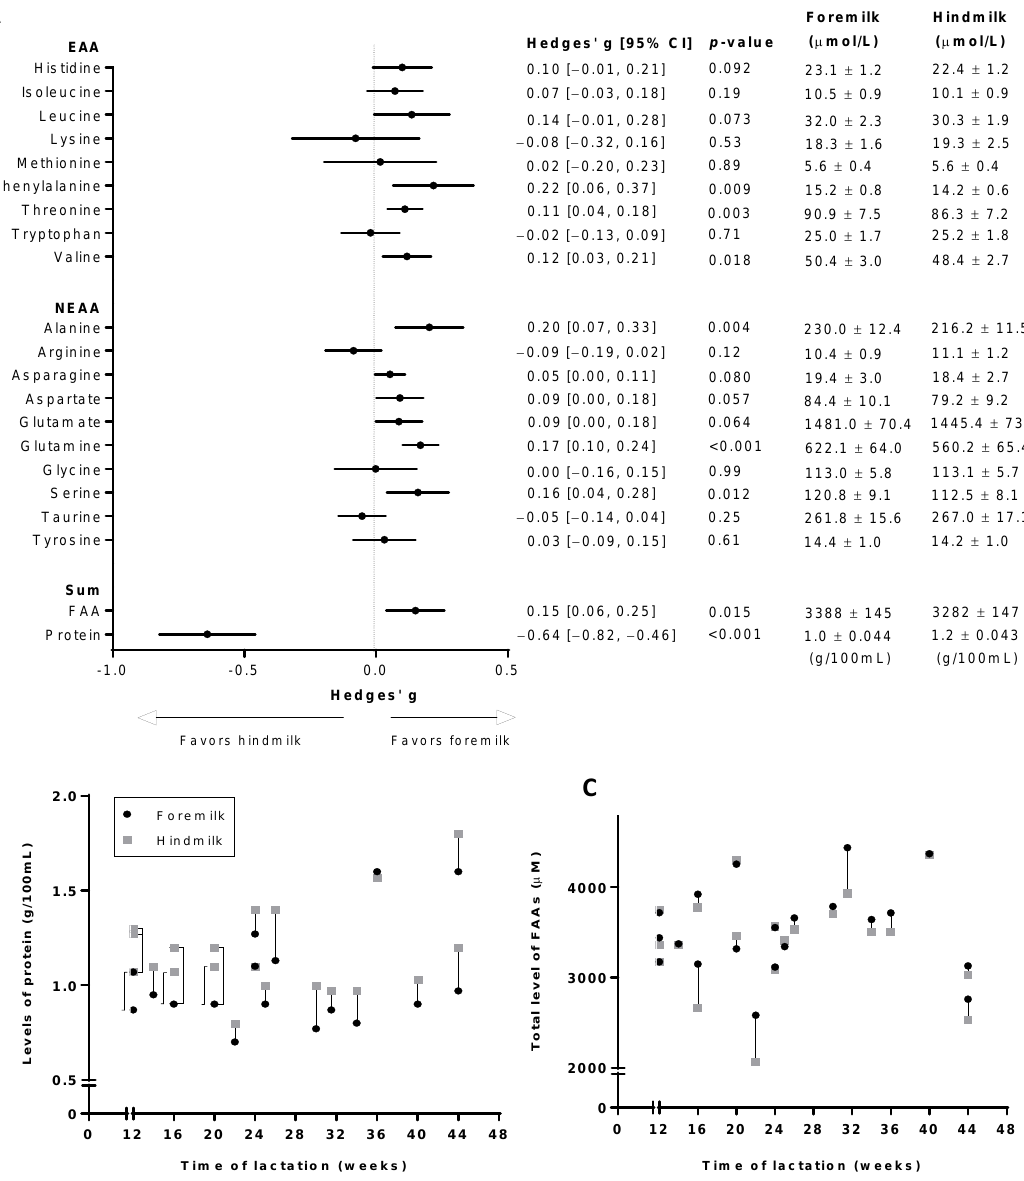
Figure 1. FAA levels in foremilk and hindmilk of thirty women. ( A ) Left: Forest plot indicating the effect sizes (Hedges’ g) of the milk fraction on the FAA and protein content in human milk. Right: average levels of FAAs and the protein content in foremilk and hindmilk samples. For each subject, total levels in hindmilk and foremilk are shown for FAAs ( B ) and protein ( C ), according to the stage of lactation of the subjects at the time of milk sampling. Average levels of FAAs in foremilk and hindmilk are shown as mean ± SEM. FAA: free amino acid; EAA: essential amino acid; NEAA: non-essential amino acid.